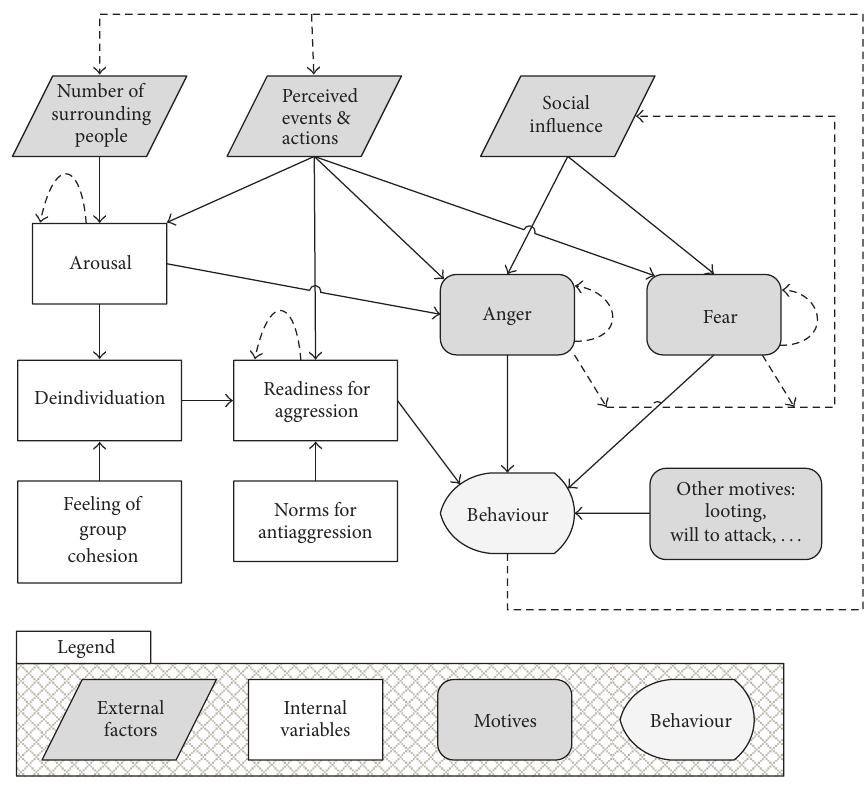
Figure 2: Key factors affecting the behaviour of civilian